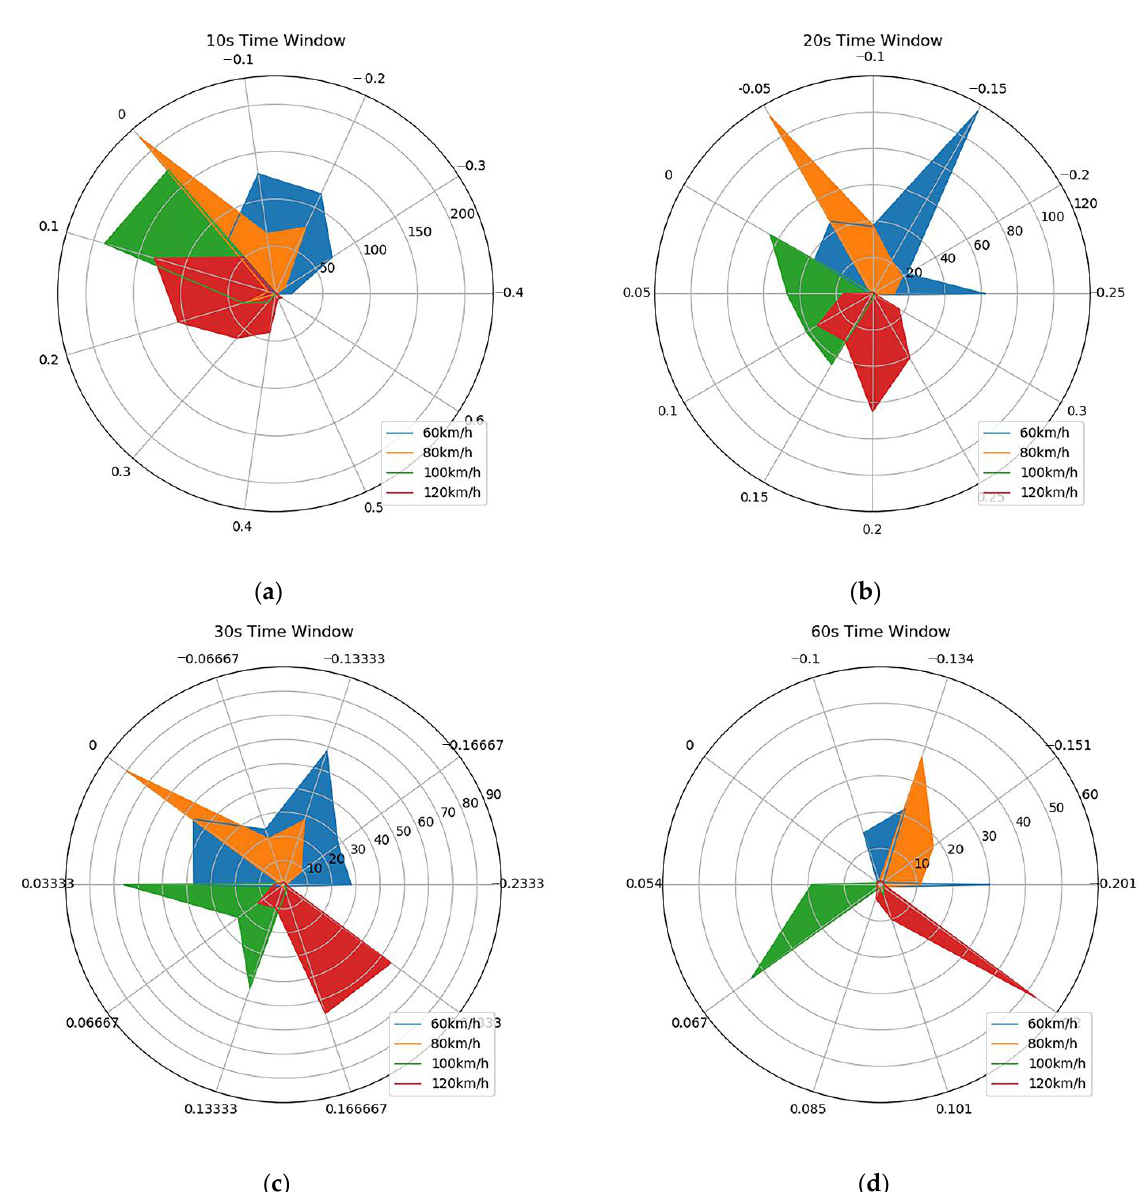
Figure 7. Radar chart of OTF data in different time windows at four vehicle speeds: ( a ) 10 s, ( b ) 20 s, ( c ) 30 s, and ( d ) 60 s.